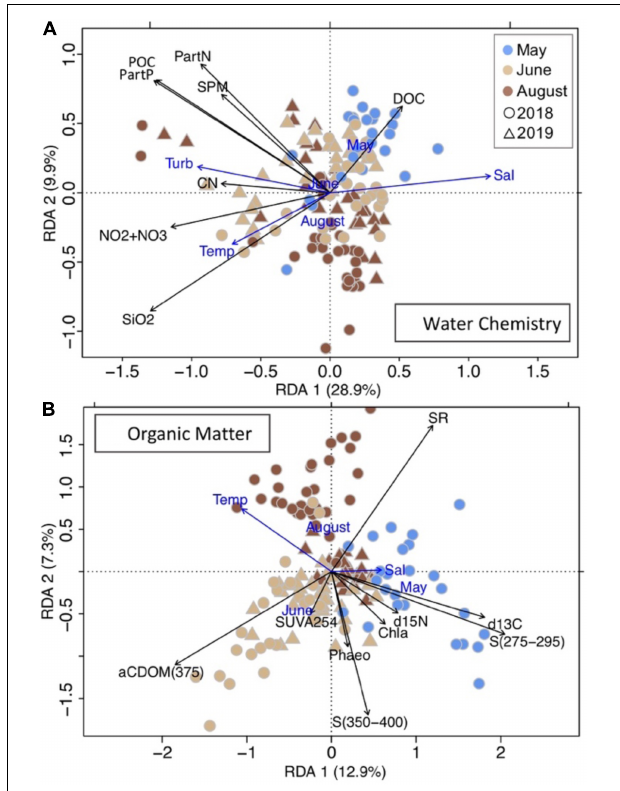
FIGURE 7 | Redundancy analyses (RDA) of (A) water chemistry parameters constrained by salinity, turbidity, temperature and sampling month (in blue), and (B) organic matter properties constrained by salinity, temperature and sampling month (in blue). Response variables unrelated to main axes ( p > 0.05) are not